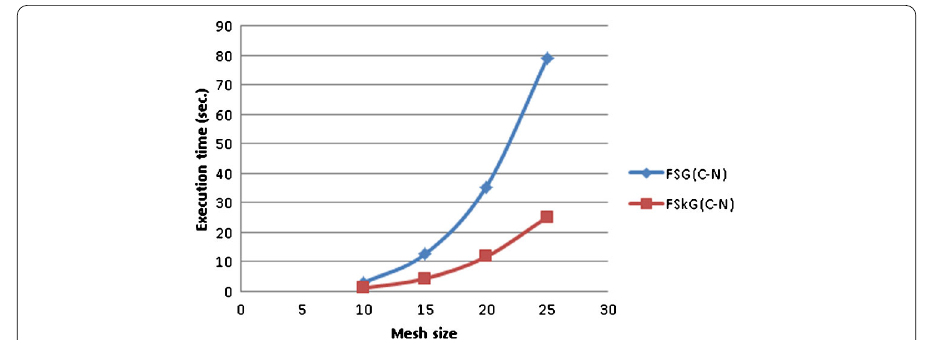
Figure 5 Graph of execution time (sec.) when α = 0.65 of Example 1